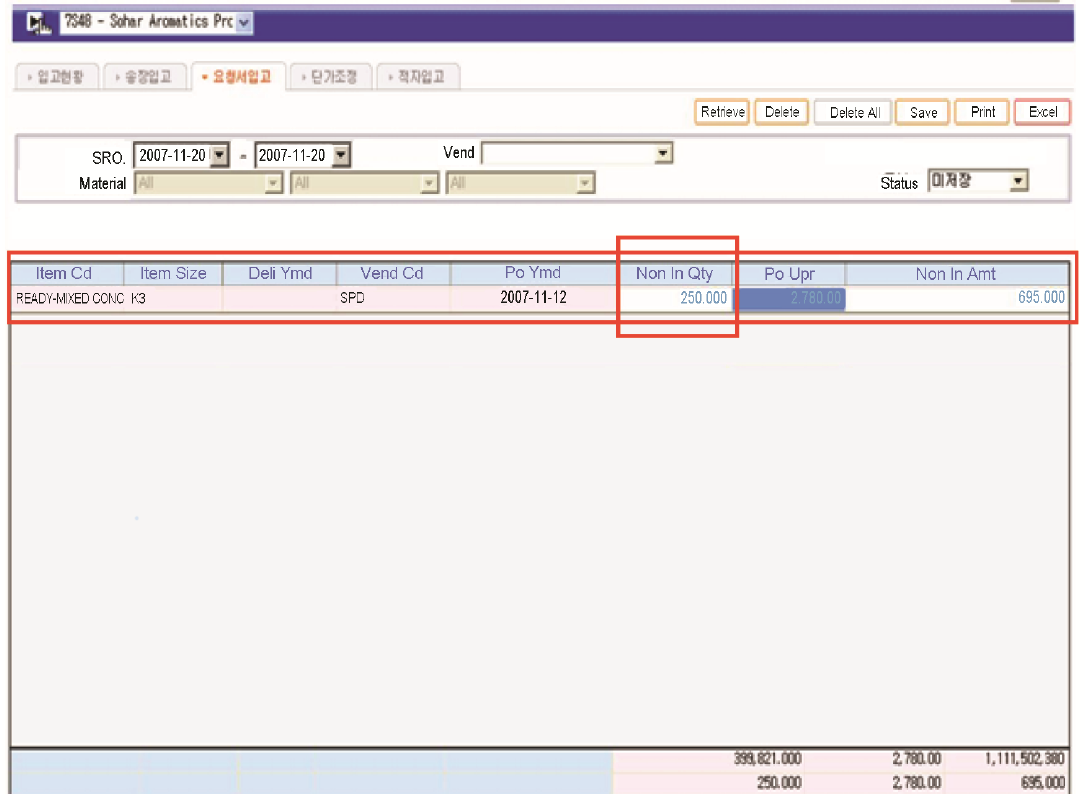
Fig. 15. Delivered-materials list from the